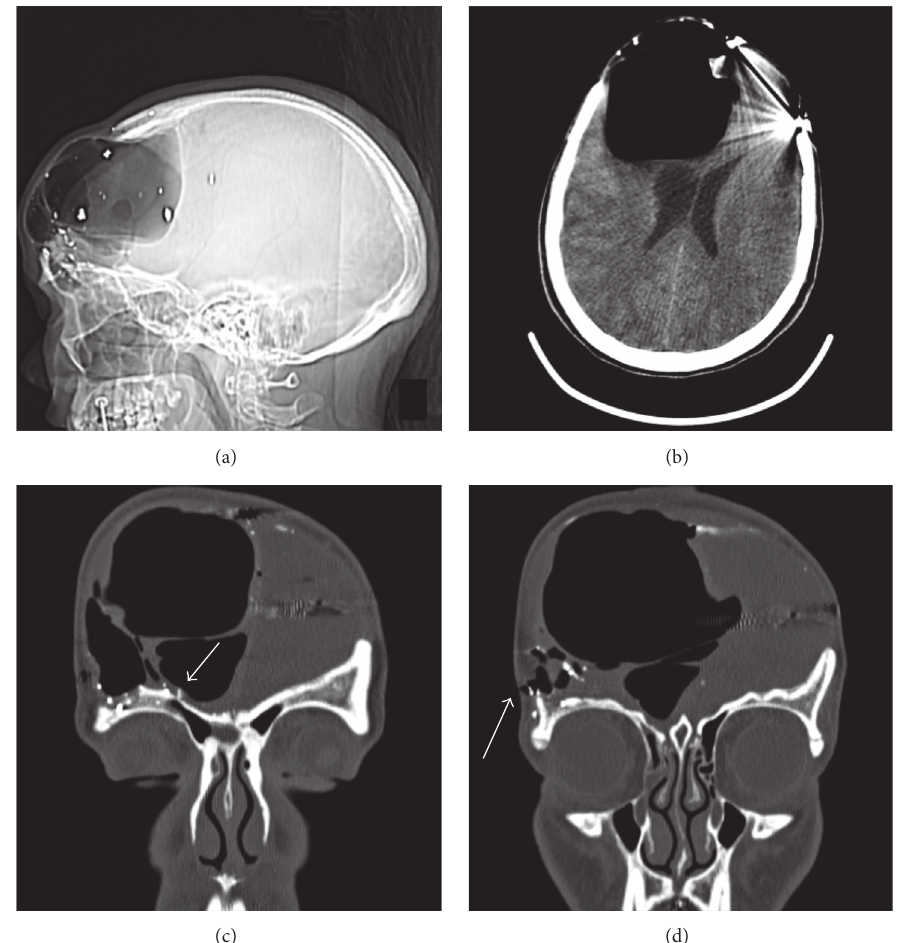
Figure 2: Readmission CT head and maxillofacial-sinus scan. (a) Scout image demonstrating a large pocket of hypodensity in the right frontalregionconsistentwithpneumocephalus.(b)AxialCTdemonstratingrightfrontaltensionpneumocephaluswithsignificantmasseffect including effacement of the right lateral ventricle, midline shift, and subfalcine herniation. (c, d) Coronal reconstructed images demonstrating air communicating through the skin in the right orbital-frontal region and a small defect with shard of bone in the superior aspect of the right frontal